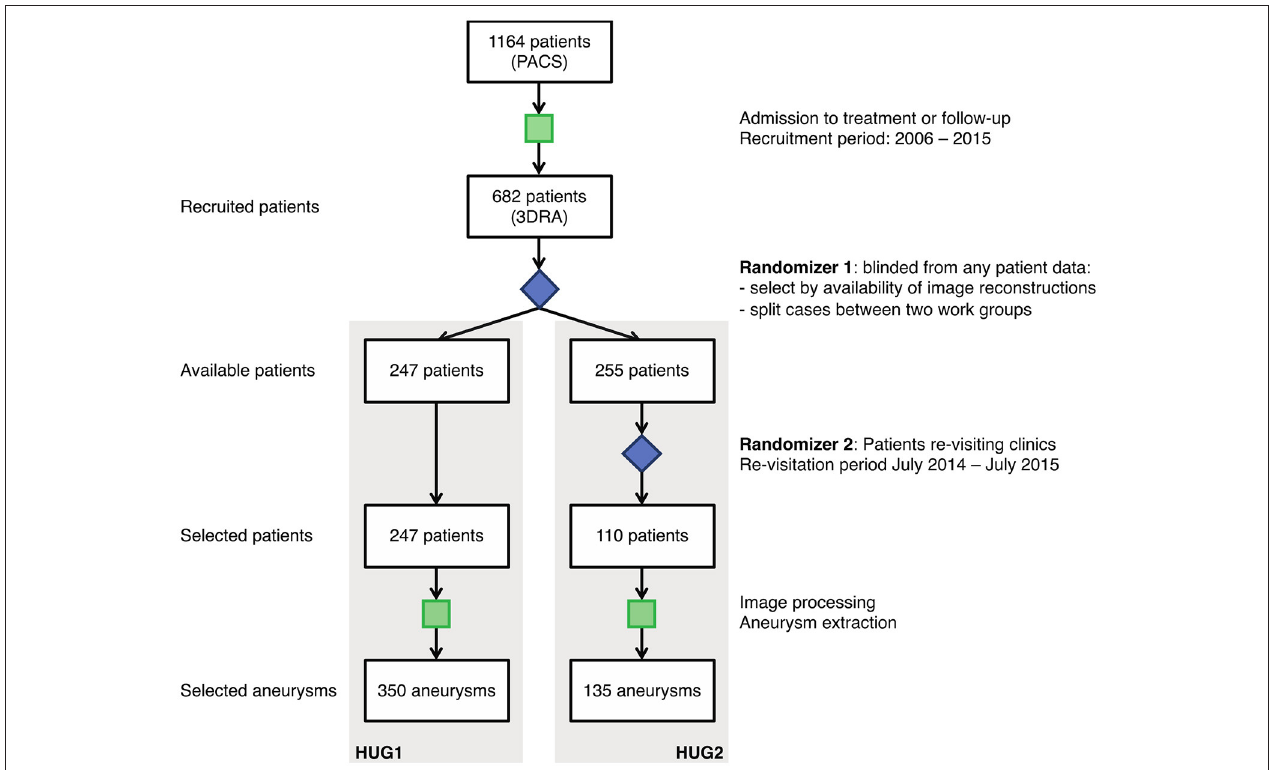
FIGURE 1 | Acquisition process for the HUG dataset. Starting from the same set of recruited patients, two teams of data curators segmented the vascular structures in 3DRA images following similar protocols.